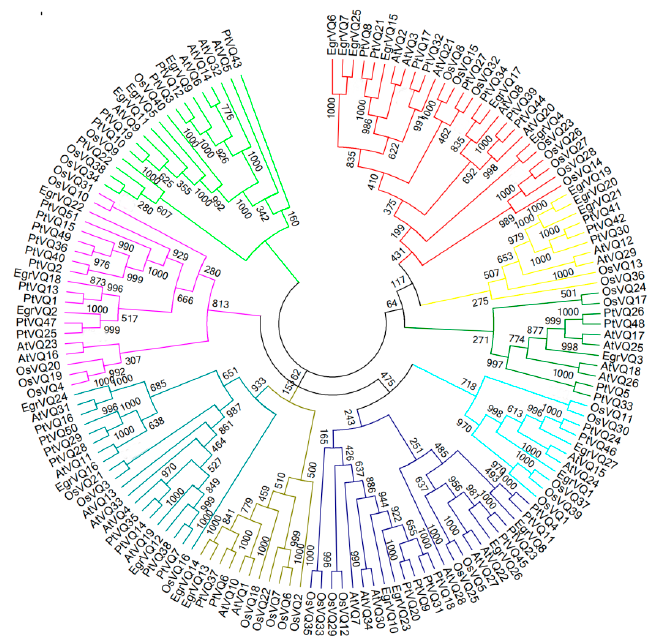
Figure 2. Phylogenetic tree of VQ proteins from E. grandis , Arabidopsis, rice, and poplar. ClustalW softwarealigned the complete amino acid sequences of 27 E. grandis (prefixed with ‘Egr’), 34 Arabidopsis (prefixed with ‘At’), 40 rice (prefixed with ‘Os’), and 51 (prefixed with ‘Pt’) VQ proteins, and MEGA 7, with 1000 bootstrap replicates, constructed the neighbor-joining tree.